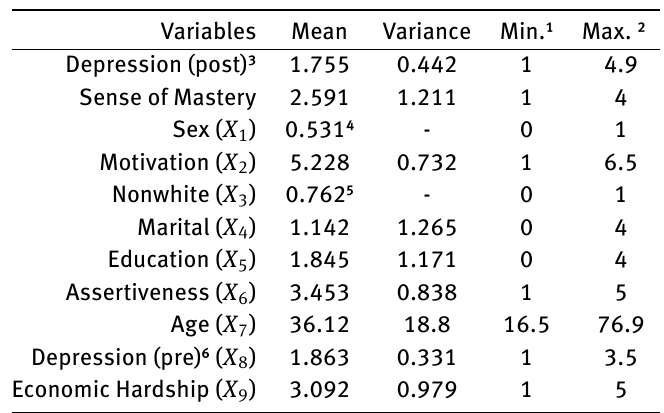
Table 1: Descriptive Statistics for JOBSII